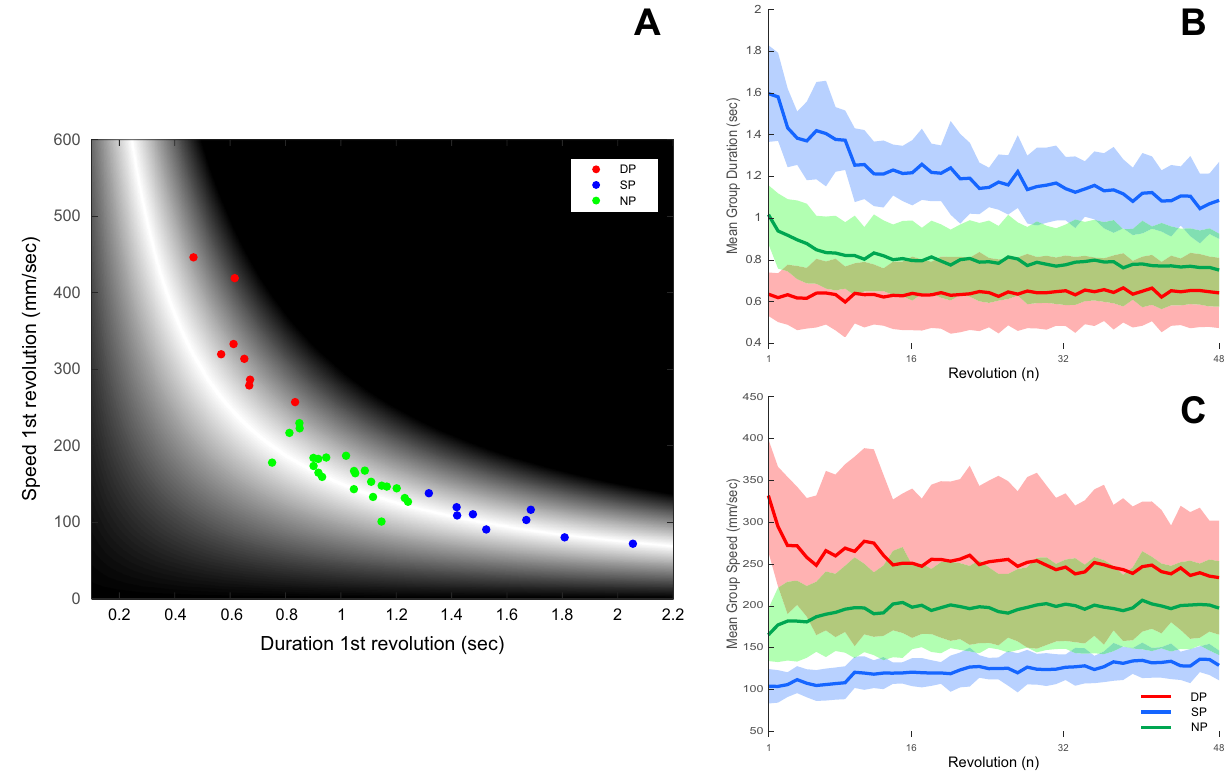
Figure 5. Group division. Subjects were subdivided into 3 groups following the implementation of k-means on the speed and duration values of the first revolution. ( A ) Scatter plot of the speed and duration values obtained on the first revolution, every dot represents a subject and is colored according to the k-means division into a Duration Preference group (i.e., DP; n = 8; red), Speed Preference group (i.e., SP; n = 9; blue) and No Preference Group (i.e., NP; n = 23; green). Arrows represent the quiver plot obtained by taking the mean of the first revolution and the last revolution for each group. ( B ) Duration results throughout the performance for the 3 groups. It is possible to note that the DP group (red) remains relatively stable compared to the SP group (blue). Specifically, the DP group mean duration measured 0.63 ± 0.104 s for the first revolution, and remained relatively stable throughout the performance reaching 0.64 ± 0.168 s by the last revolution. The SP group measured 1.59 ± 0.23 s for the first revolution, reaching 1.08 ± 0.18 s by the last revolution, and the NP group measured 1.01 ± 0.14 s for the first revolution, reaching 0.75 ± 0.174 s by the last revolution. ( C ) Speed results throughout the performance for the 3 groups, demonstrating that SP group (blue) remains relatively stable compared to the DP group (red). Specifically, the DP group averaged 331.6 ± 67.2 mm/s for the first revolution, reaching 233.8 ± 68.05 for the last revolution. The SP group averaged 104.2 ± 20.5 mm/s for the first revolution and remained relatively stable measuring 129.1 ± 17.7 mm/s by the last revolution. The NP group averaged 165.5 ± 31.1 mm/s for the first revolution, increasing to 197.4 ± 55.9 mm/s by the last